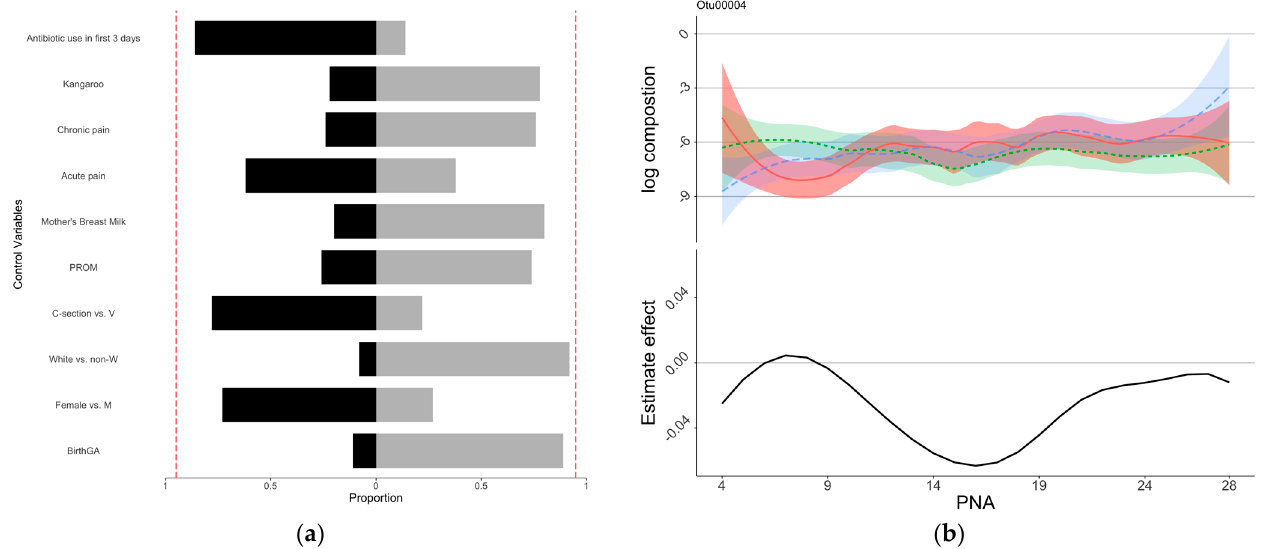
Figure 4. Control sign and OTUs for NQMOVE. ( a ) Control sign and NQMOVE. ( b ) OTUs associated with NQMOVE scores. ( a ) The proportions of the signs of the estimated coefficients of the control variables. Proportions of negative signs were shown as black blocks to the right, and those of positive signs were shown as light gray blocks to the left. Higher NQMOVE scores indicated better development, those variables in light gray indicated association with higher NQMOVE scores. The red do tt ed lines show the 90% of bootstrap. ( b ) The estimated time-varying e ff ects of OTU on NQMOVE scores during the NICU stay. The x-axis represents the days after birth (PNA, postnatal age), the y-axis represents the log composition of the OTU abundance (top panel) and the estimated e ff ect (bo tt om panel). The top panel “log composition” displays the trend of the log-transformed OTU compositions over the fi rst 28 days of NICU stay for infants with di ff erent NQMOVE scores, with the infants being separated into three groups based on their NQMOVE score: high NQMOVE score (plo tt ed in red), medium NQMOVE score (plo tt ed in green), and low NQMOVE score (plo tt ed in blue). The bo tt om panel “Estimate e ff ect” is the estimated time-varying e ff ects of OTU on NQMOVE scores during the NICU stay. To illustrate the relationships between gut microbiota compositions and NNNS sub- scales (NSTRESS, NHANDLING, and NQMOVE), the standardized scores of each these subscales were plo tt ed with the gut microbiome for each infant using a heatmap (Figure 1). A standardized score of the NNNS subscales was generated by dividing the di ff erence between each infant’s score and the mean by the standard deviation. Eight OTUs were identi fi ed to be associated with NNNS subscales through the re- gression analysis (Figures 2–4, and Supplementary Table S4). At the taxonomy levels, fi ve belong to Firmicutes (OTU4, OTU5, OTU6, OTU8, and OTU28), and three belong to Prote- obacteria (OTU1, OTU2, and OTU17). The taxa of OTU1 ( Enterobacteriaceae_unclassi fi ed ), OTU2 ( Escherichia-Shigella ), and OTU17 ( Enterobacteriaceae_unclassi fi ed ) were identical at